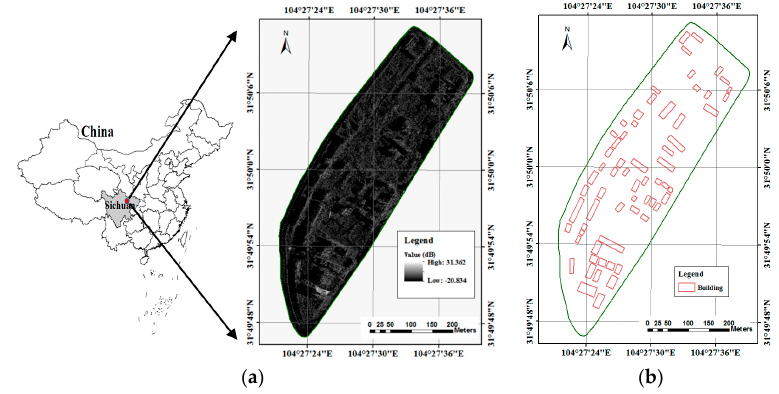
Figure 8. The study area: ( a ) a post-earthquake descending SAR image (the azimuth direction is from top to bottom, and the range direction is from right to left); and ( b ) building footprint map.